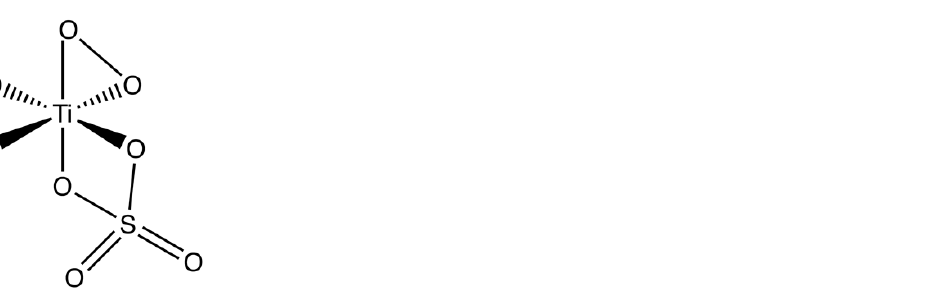
Figure 1. The suggested mononuclear complex with a peroxide dianion chelating to a titanium center (see text for more information).